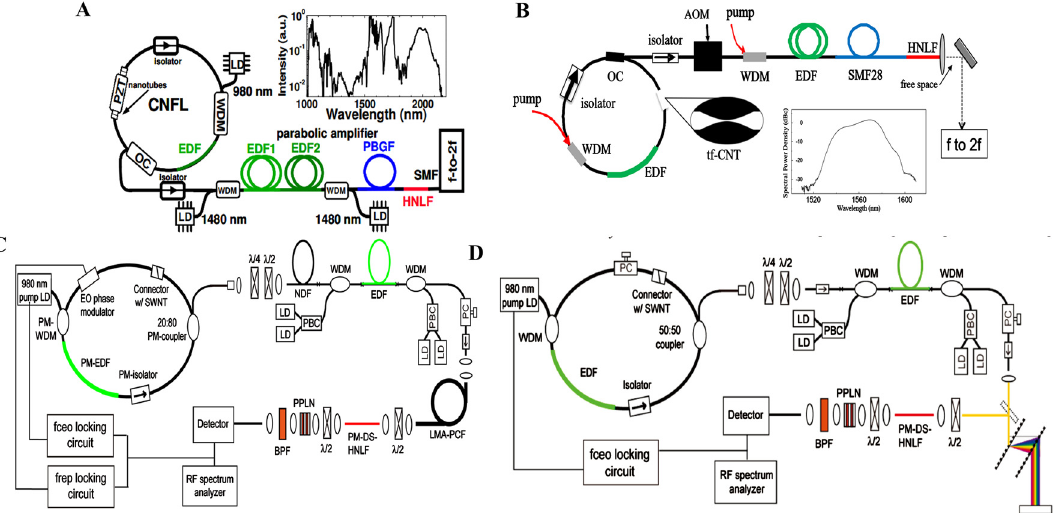
Figure 9: Typical experimental setup of OFC system using CNT SA mode-locked fiber laser. (A) The first self-referenced frequencycombfrom a CNT mode-locked fiber laser.Lim et al.[253]. ©Optical Societyof America2009. (B)A fi ber frequencycombbasedonatapered- fi berCNTdesign.Wuetal.[254].©OpticalSocietyofAmerica2011.(C)AnOFCsystembasedonanall-PM Er-doped fi ber laser with SWNT PI fi lm. Nishizawa et al. [259]. Author copyright. (D) An OFC system based on a dispersion managed Er-doped fi ber laser with SWNT PI fi lm. Nishizawa et al. [260]. Author copyright. CNT SA, carbon nanotube saturable absorber; OFC, optical frequency comb; SWNT PI, single walled carbon nanotube